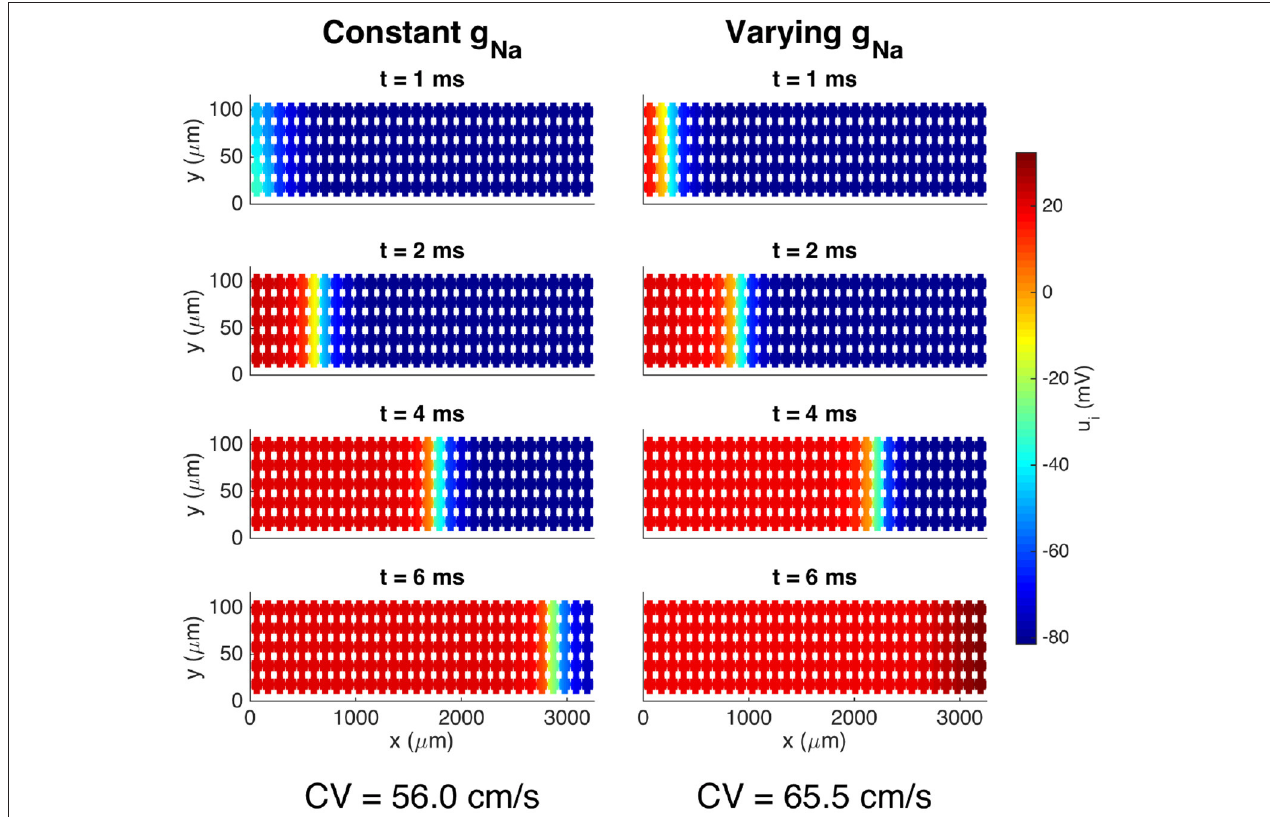
FIGURE 7 | Intracellular potential at four points in time for a collection of cells with two different distributions of the sodium channel conductance. In the case of a constant g Na , the value is g Na = 23 mS/ µ F on the entire membrane, and in the case of a varying g Na , the value is g Na = 783 mS/ µ F on (cid:127) W and (cid:127) E and zero elsewhere. The solutions are obtained using the FDM and the parameters used in the simulations are given in Tables 1 , 6 , except that we use 1 t = 0.01 ms. We apply a 1-ms-long stimulus current of 120 µ A/ µ F for the 2 × 2 cells in the lower left corner of the domain.